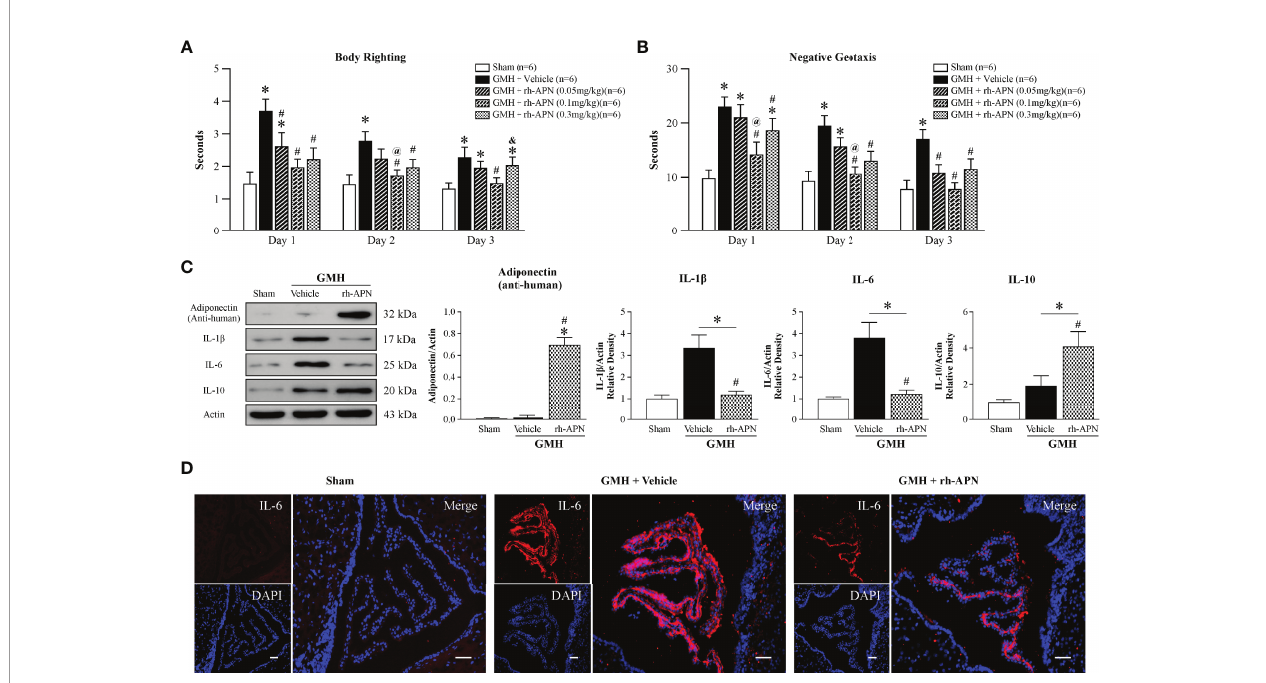
FIGURE 2 | Intranasal administration of Adiponectin improved short-term neurological function at 72 h post-GMH. (A) Righting re fl ex and (B) Geotaxis re fl ex tests revealed that the medium dosage (0.1mg/kg) of rh-APN signi fi cantly improved neurological function when compared with the vehicle-treated pups at 1, 2, and 3 d post-GMH. Values are expressed as mean ± SD. ANOVA, Dunnett. n = 6-9 for each group. * P < 0.05 compared to sham, # P < 0.05 compared to GMH + Vehicle, @ P < 0.05 compared to GMH + rh-APN (0.05mg/kg), & P < 0.05 compared to GMH + rh-APN (0.1mg/kg). (C) Western blot data showed that intranasal administration of rh-APN after GMH could be delivered successfully into brain tissue, and it reduced proin fl ammatory cytokine levels of IL-1 b and IL-6 while increasing expression levels of anti-in fl ammatory cytokine, IL-10, within the brain. ANOVA, Dunnett. n = 6 for each group. * P < 0.05 compared to sham, # P < 0.05 compared to GMH + Vehicle. (D) Immuno fl uorescence staining assay showed IL-6 immunoreactivity in the choroid plexus was dramatically increased in pups that were subjected to GMH when compared with sham, and rh-APN treatment signi fi cantly reduced the IL-6 immunoreactivity compared to